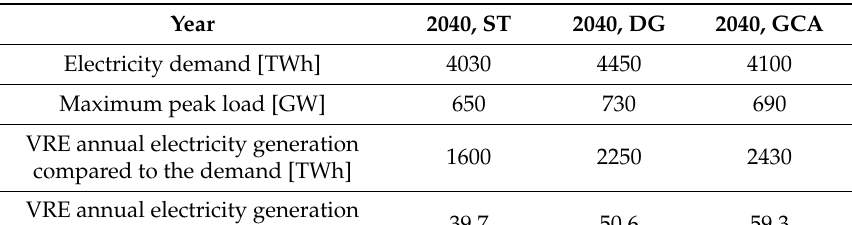
Table 3. European electricity consumption and maximum peak load features in 2040 based on the examined scenarios [27].